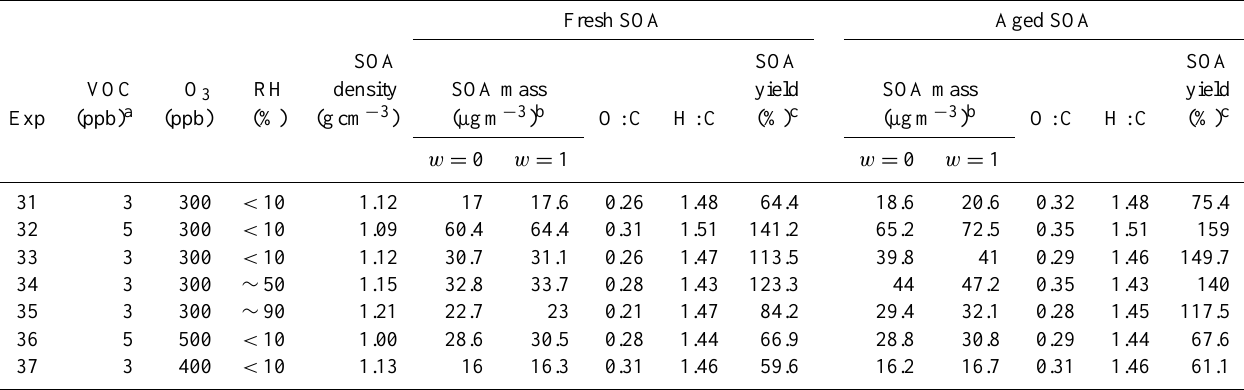
Table 2. Initial conditions and results of the aging experiments. Fresh SOA Aged SOA SOA SOA SOA density SOA mass yield SOA mass yield